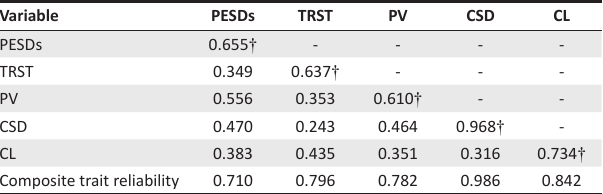
TABLE 4: Average variance extracted, squared interconstruct correlations and composite trait reliability. Variable PESDs